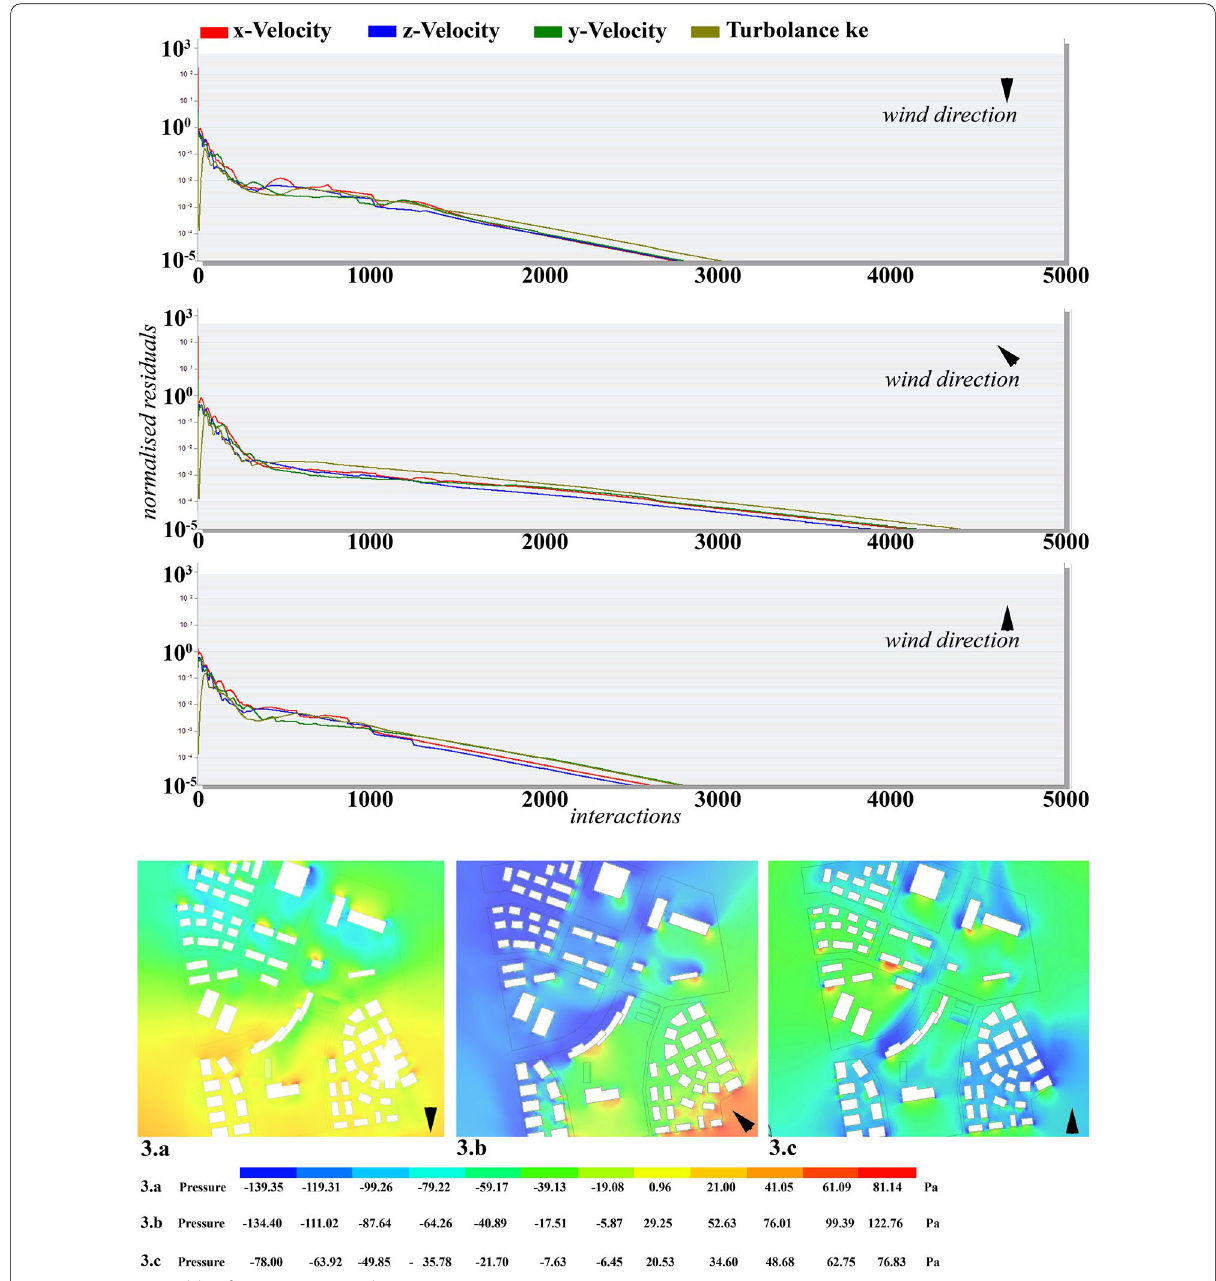
Fig. 9 Case no. 3: table of convergence and pressure map